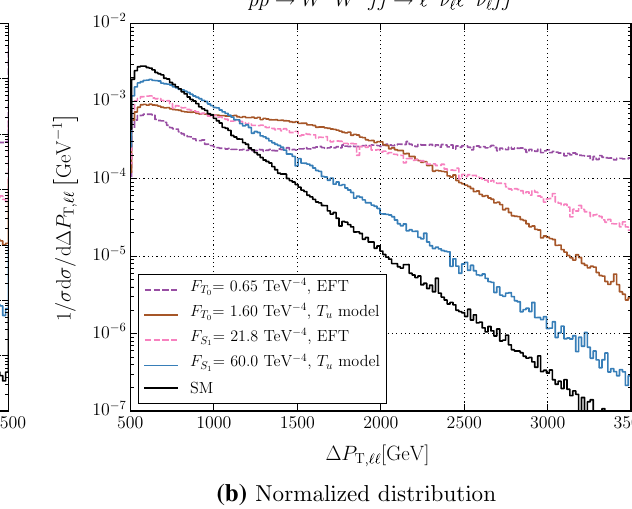
solid blue and brown lines show the corresponding T u model for O S and O T . Beyond the cuts in Eq. (34) we impose m (cid:6)(cid:6) > 500 0